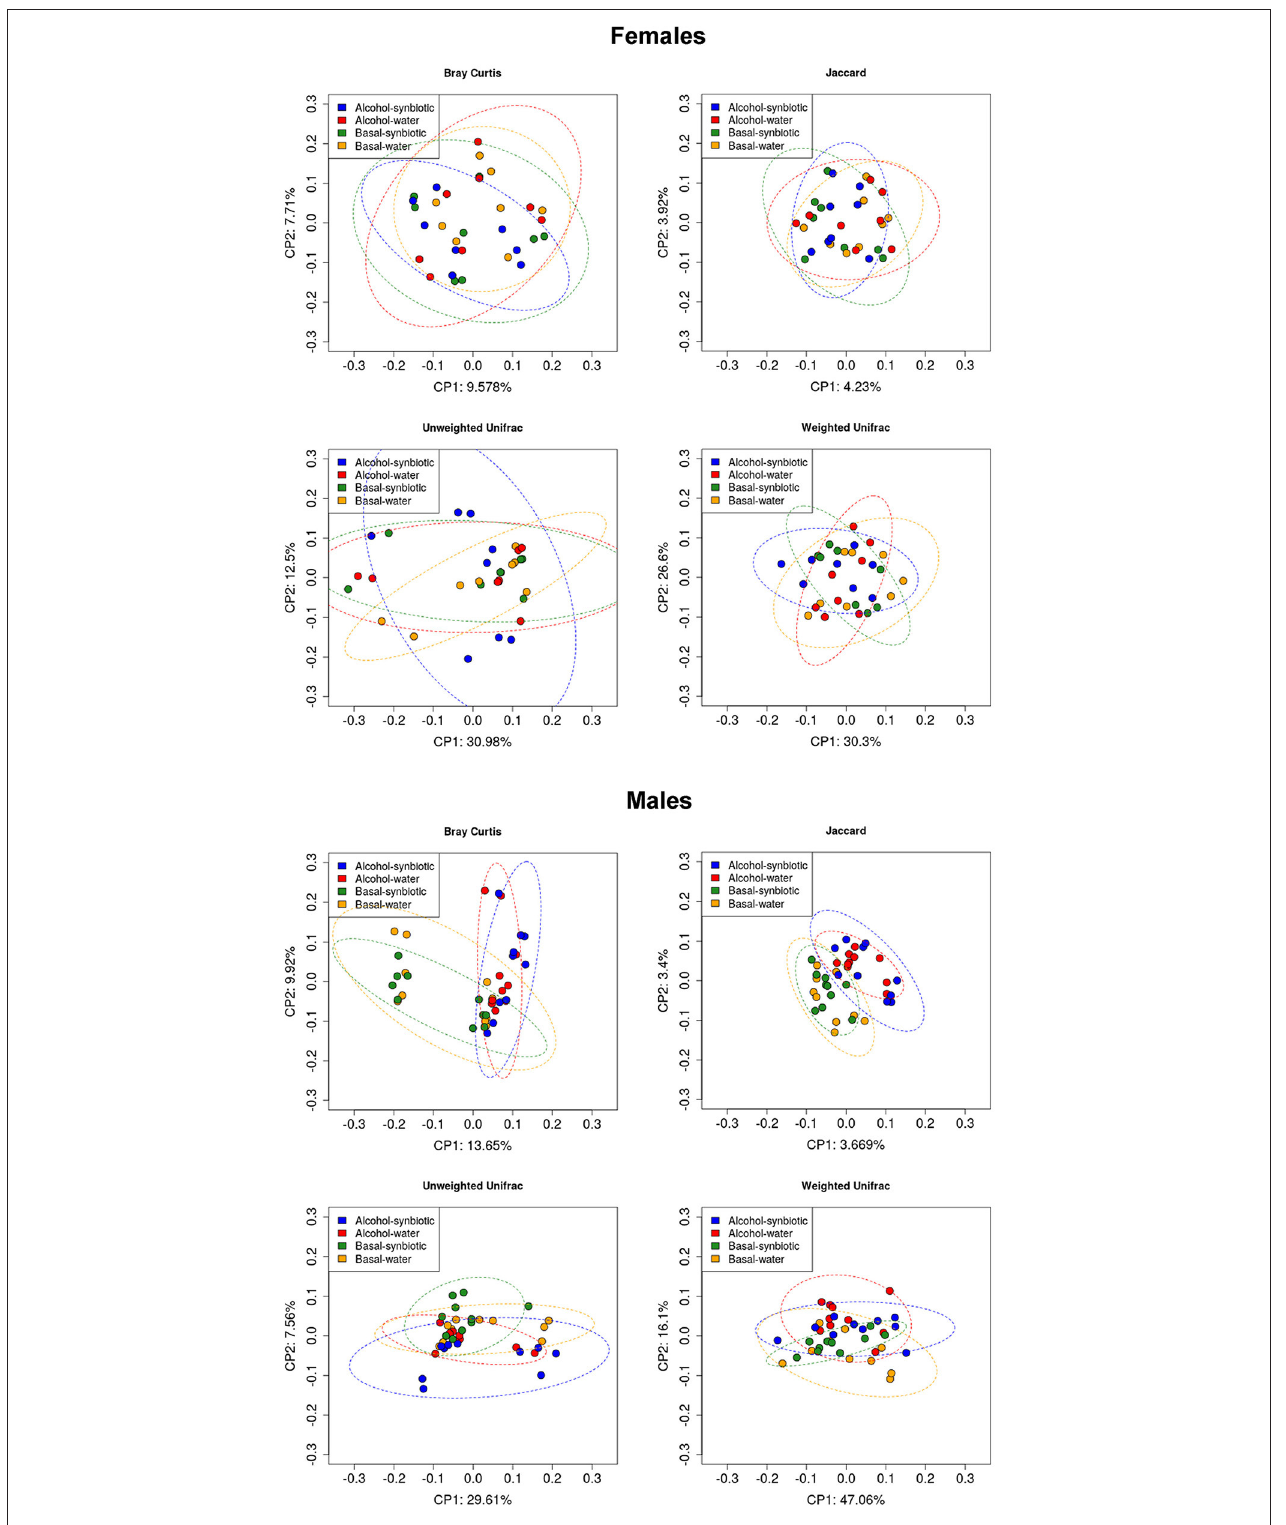
FIGURE 6 | Principal component analysis (PCoA) for microbial community composition and structure (Beta diversity) in fecal samples of females and males under basal conditions (no alcohol), and following intermittent alcohol (15% ethanol solution in water) intake, in mice exposed to water or synbiotic. The data represent Unifrac phylogenetic-based distances for Bray Curtis, Jaccard, Unweighted, and Weighted Unifrac indexes.